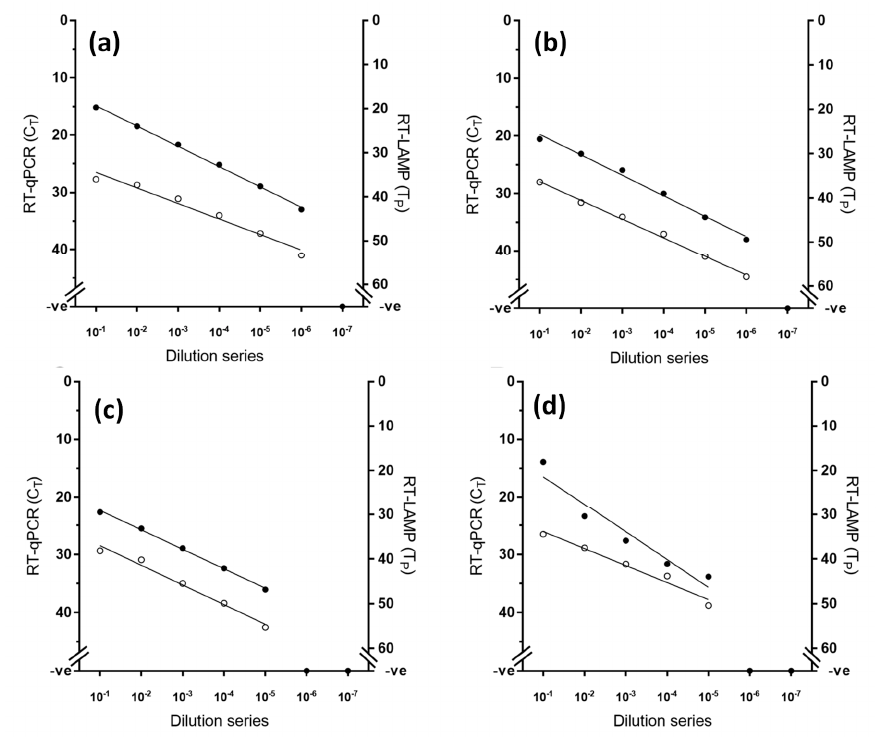
Figure 2. Comparative analytical sensitivity of peste des petits ruminants virus RT-LAMP (open circles) and the gold standard RT-qPCR (closed circles) for four di ff erent lineages of PPRV ( a ) lineage I (PPRV / Ivory Coast), ( b ) lineage II (PPRV / Nigeria / 76 / 1), ( c ) lineage III (PPRV / IBRI-Oman) and ( d ) lineage IV (PPRV / Morocco /